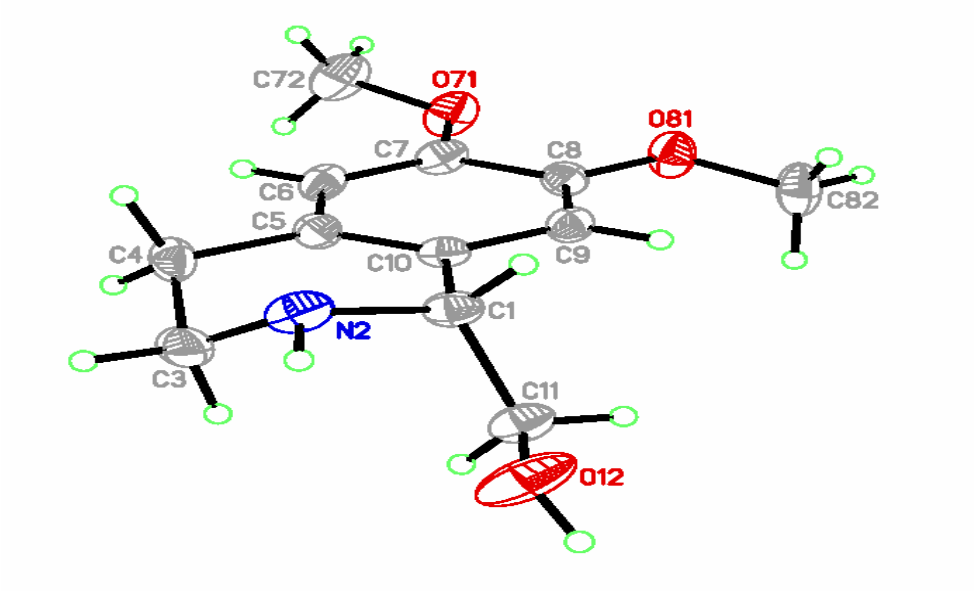
Table 1. Selected bond lengths and angles of 1